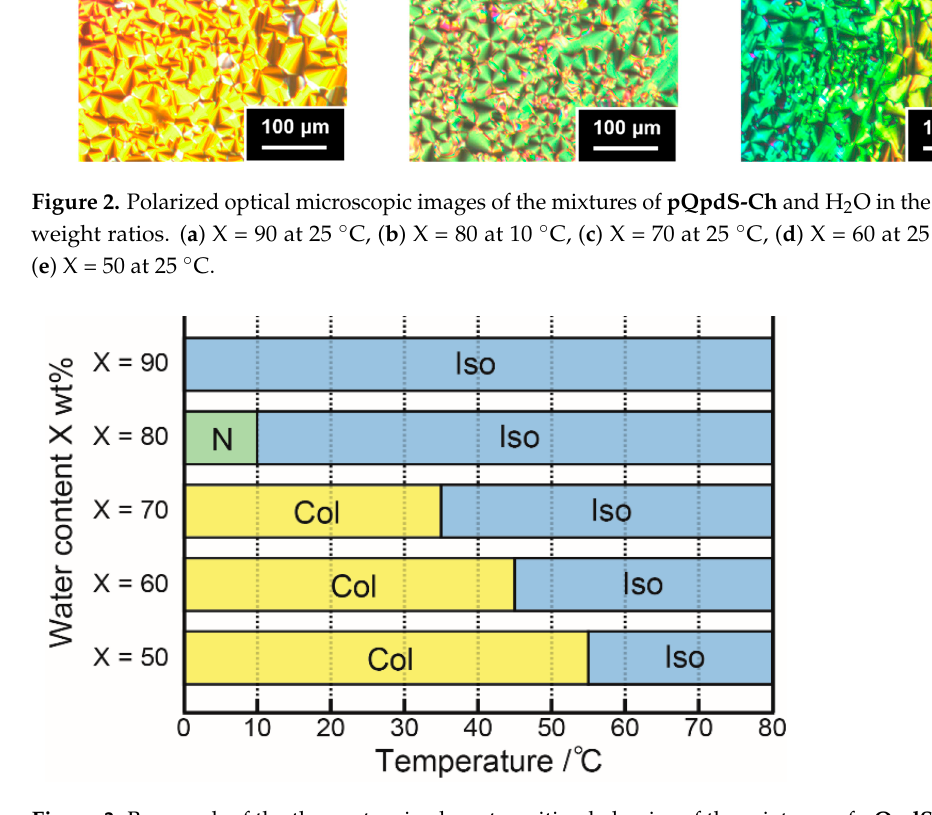
Figure 3. Bar graph of the thermotropic phase transition behavior of the mixtures of pQpdS-Ch and H 2 O in the 100–X:X weight ratios on cooling.